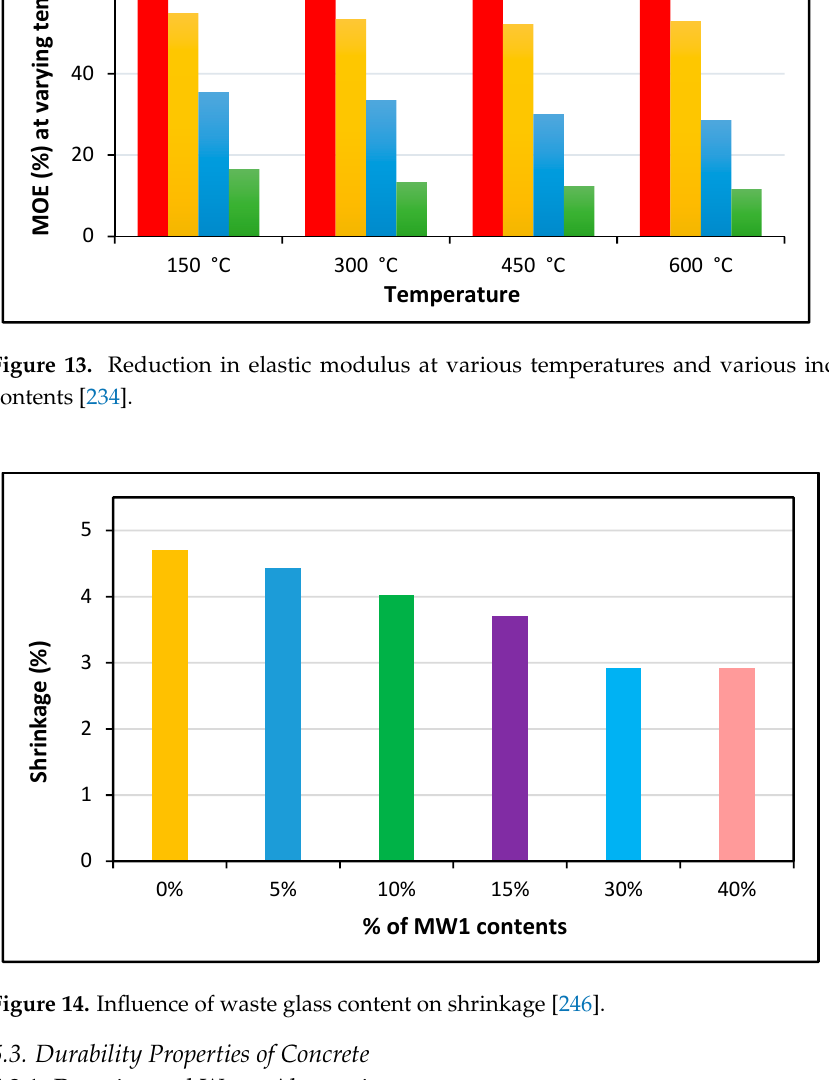
Figure 14. Influence of waste glass content on shrinkage [246].